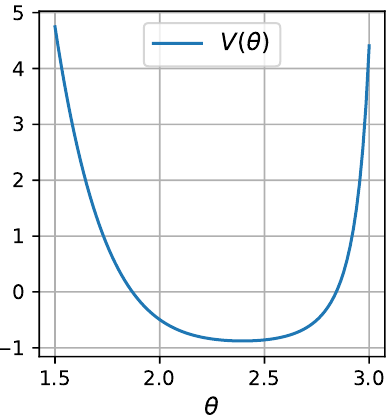
Figure 4 . The Euclidean potential for the dS-AdS domain wall. The parameter choices are (cid:20) = 0 : 35 B and B 0 = 1 : 6 B